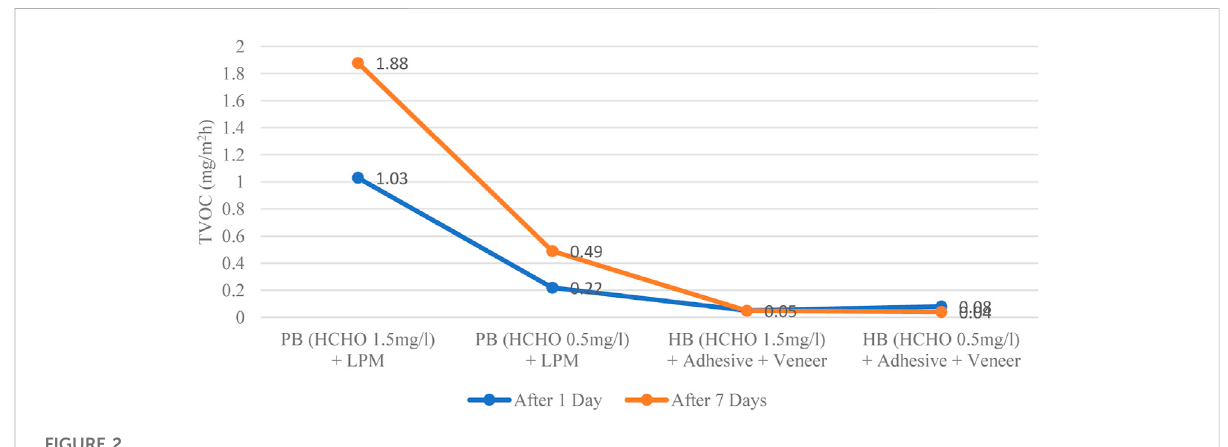
FIGURE 2 TVOC emission intensity according to different raw